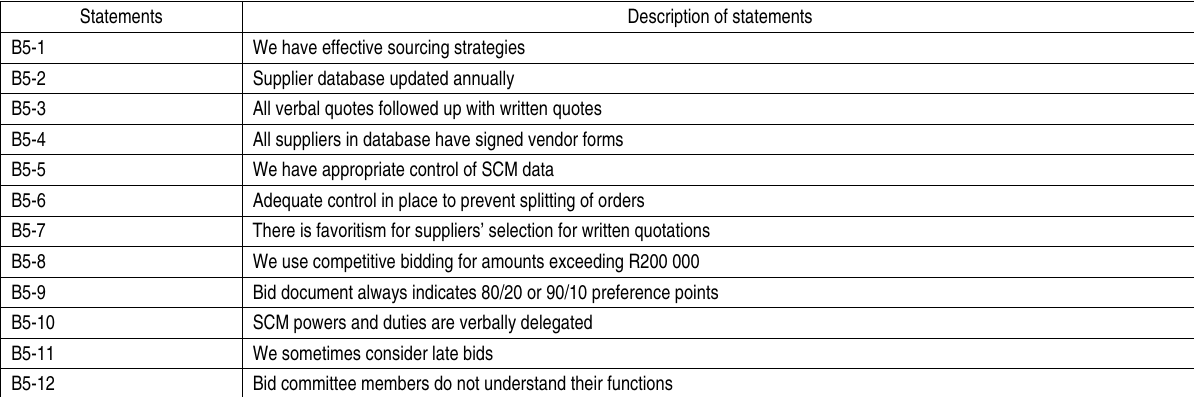
Table 5. Description of statements used in Table 4 relating to acquisition management